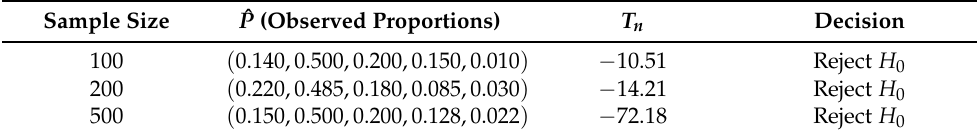
Table 10. Application of the equivalence test to classification of slopes: Case #2.